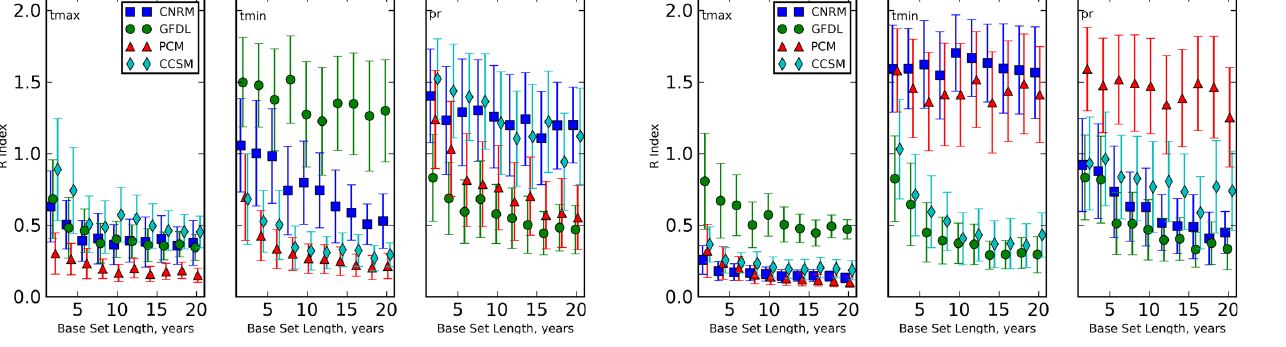
Fig. 9. For cell number 2 (see Fig. 1), R index values for base set sizes from 2 to 20yr. Points are for the mean R value for the me- dian values of the variables; the bar indicates one standard deviation centered around the point.